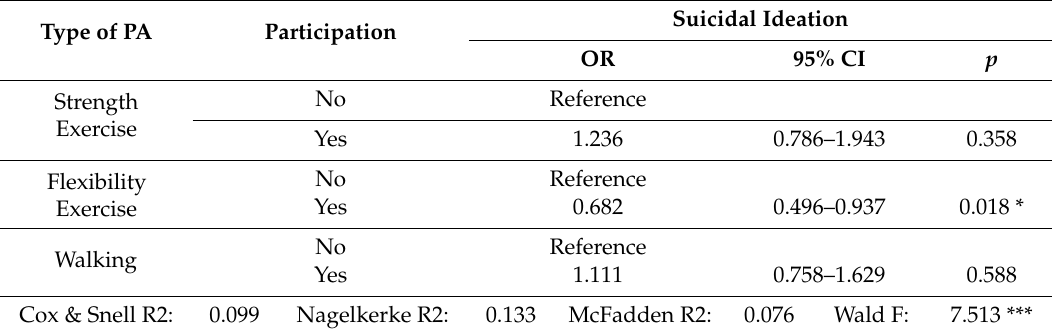
Table 3. Results of the e ff ects of physical activity (e.g., strength exercise, flexibility exercise, walking) on suicidal ideation in adult women with depressive disorder by logistic regression